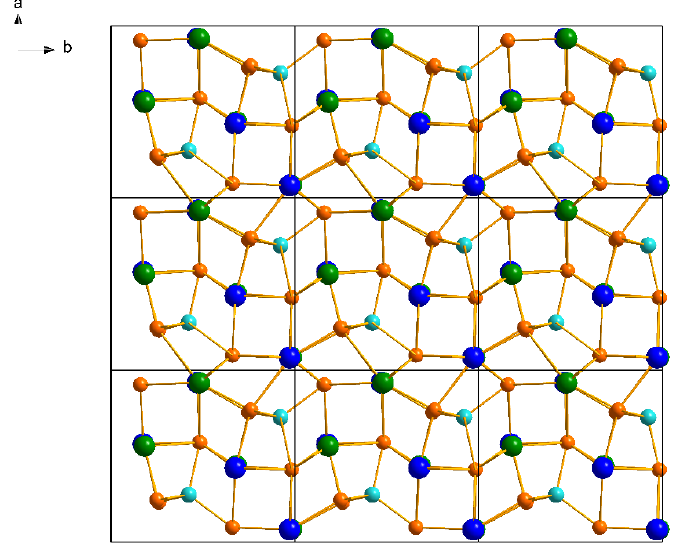
Figure 9. The crystal structure of cerromojonite projected down [001] (six unit-cells). The unit-cell and